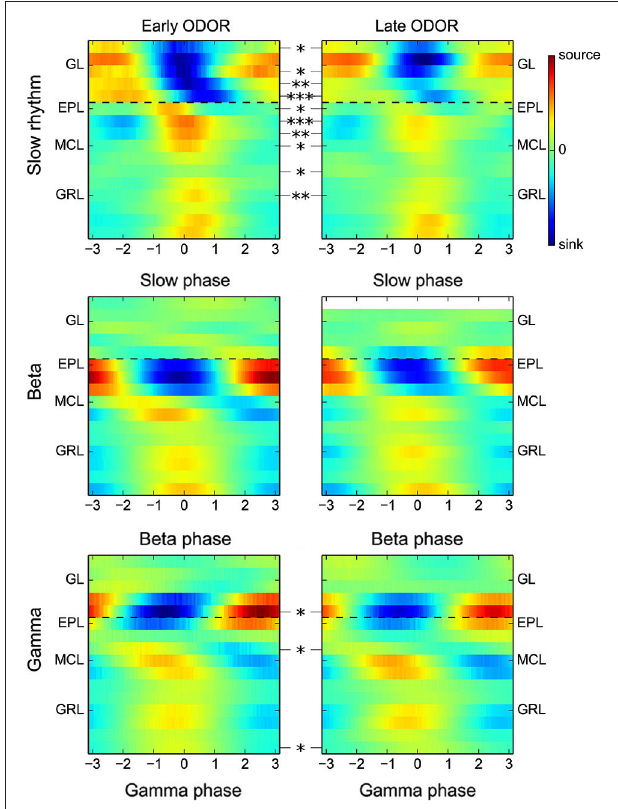
FIGURE 5 | Stability of gamma and beta CSD maps over the course of odor presentation. Group CSD maps computed for either the slow oscillations (range 0.5–5 Hz, top panel), beta oscillations (middle) or gamma oscillations (bottom) at the beginning of the ODOR period (0–1 s, left) or at the end of the ODOR period (3–5 s, right). Statistical analyses of the CSD map amplitude show a marked decrease of the CSD modulation amplitude in the MCL, EPL and GL layers for the slow oscillation, but no or very few significant changes for beta and gamma oscillations. In addition, the spatial organization of fast oscillation CSD maps is unchanged between the early and late ODOR period (dashed black lines are visual